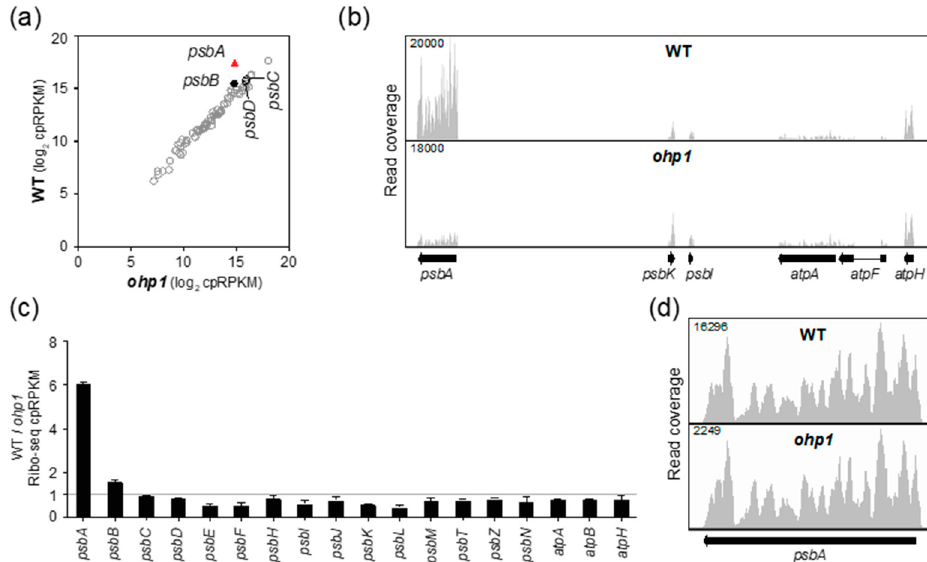
Figure 3. Ribo-seq analysis of Arabidopsis ohp1 mutants. Data for a replicate experiment are shown in Figure S1b. Symbols and nomenclature are as described in Figure 2. ( a ) Comparison of ribosome footprint abundance for all chloroplast genes in ohp1 mutants to that in phenotypically-normal siblings. ( b ) Screen capture from the Integrated Genome Viewer (IGV) showing the distribution of ribosome footprints along psbA and adjacent ORFs. Different genes are displayed here and in Figure 2b due to the different gene order in the maize and Arabidopsis chloroplast genomes. ( c ) Ratio of Ribo-seq reads in the wild-type relative to the mutant for chloroplast genes encoding PSII subunits. Several atp genes are shown for comparison. The average of the two replicates (+/– SD) is shown. ( d ) Distribution of ribosome footprints along the psbA ORF. The Y-axis maxima were adjusted to facilitate comparison of ribosome distributions in the two genotypes.